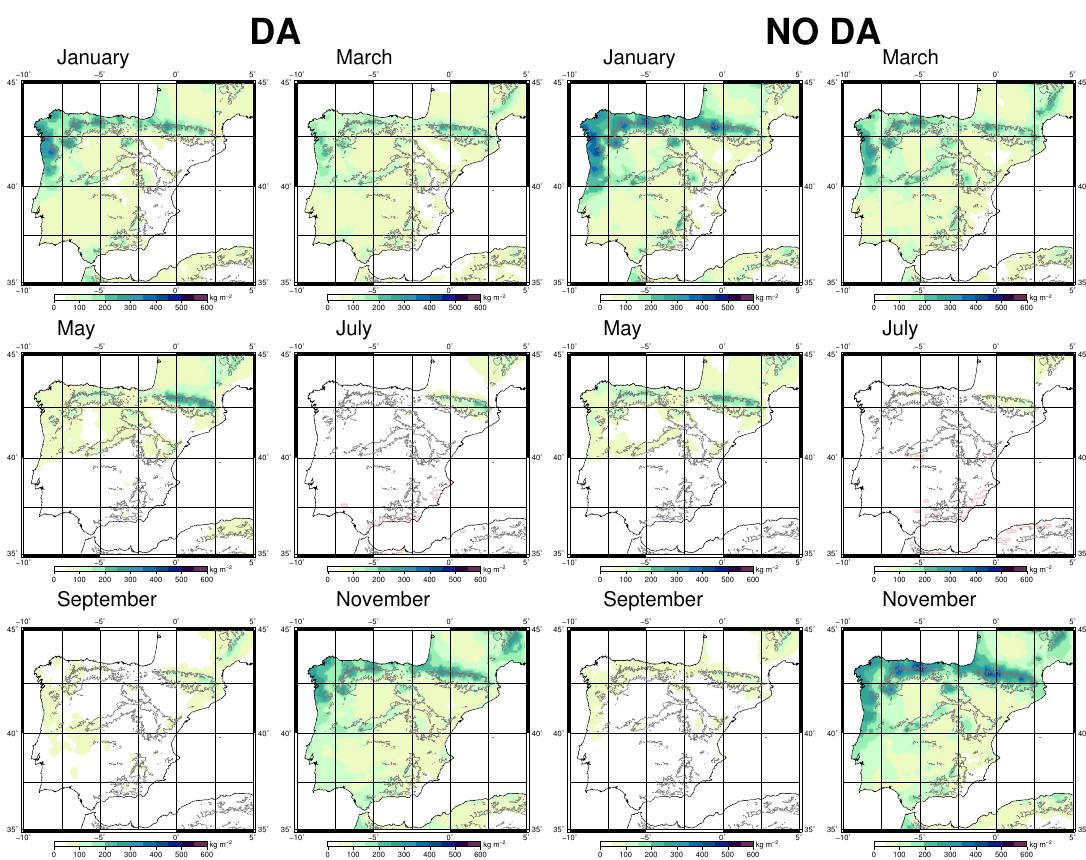
Figure 5. Spatial distribution of accumulated precipitation (kg/m 2 or mm) for different months of both WRF simulations; First, two columns belong to WRF D, and the other two to WRF N. The topography of the IP, as represented in the ETOPO1 dataset [64], is also